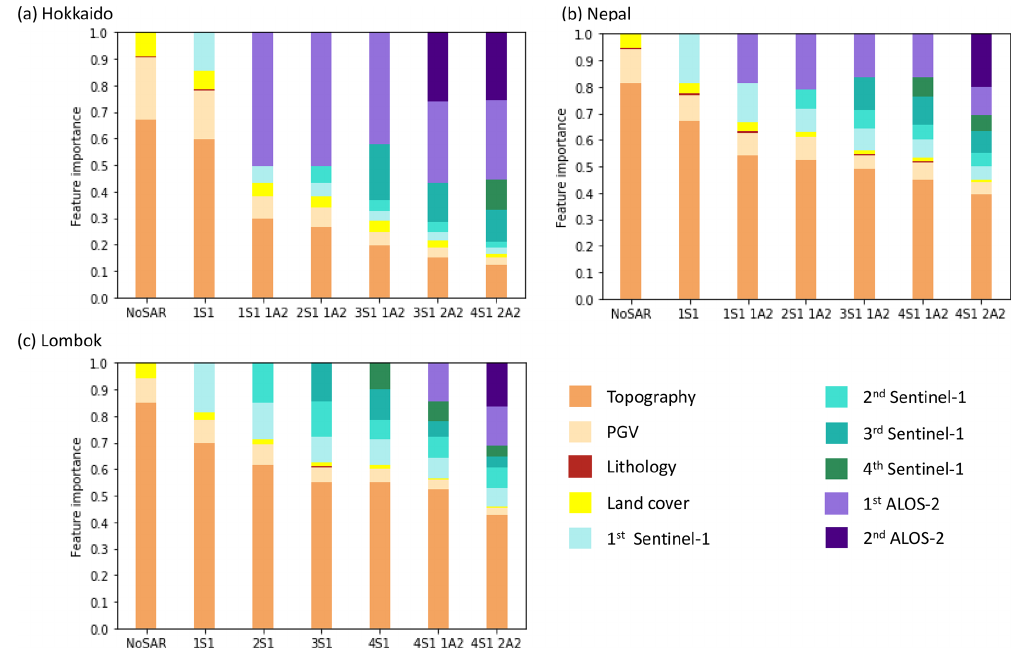
Figure 6. The relative importance of the different input datasets as ICFs generated from Sentinel-1 (S1) and ALOS-2 (A2) SAR data are added to the model for models trained on balanced landslide data mapped following (a) the 2018 Hokkaido, Japan, earthquake; (b) the 2015 Gorkha, Nepal, earthquake; and (c) the 2018 Lombok, Indonesia,